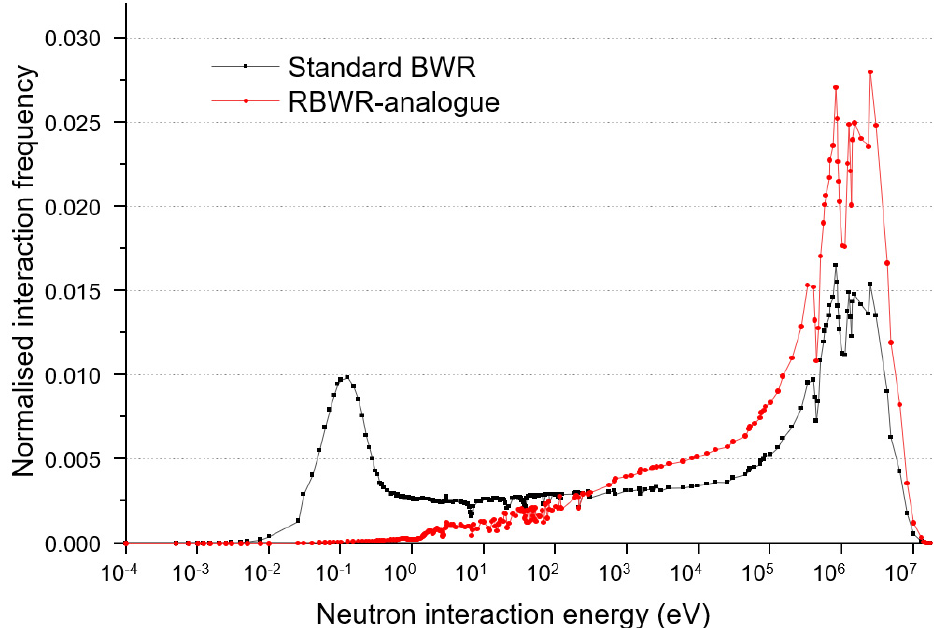
Figure 8. Comparison of neutron energy distribution between the RBWR-analogue calculated reactor used in this work and a standard BWR as calculated from a simple example case from the SCALE user guide. Both calculations were run at steady state before any depletion.